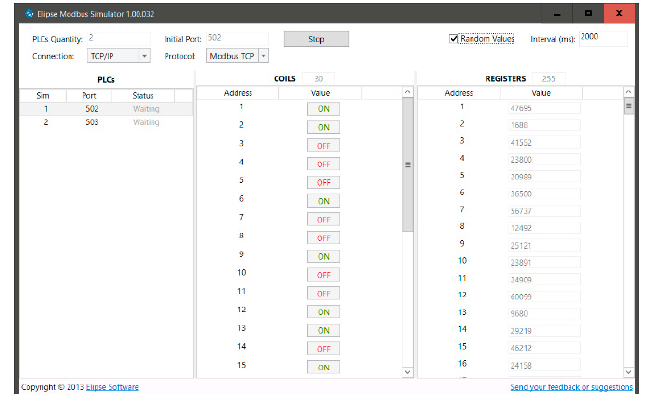
Figure 12. Modbus slave in Modbus simulator.